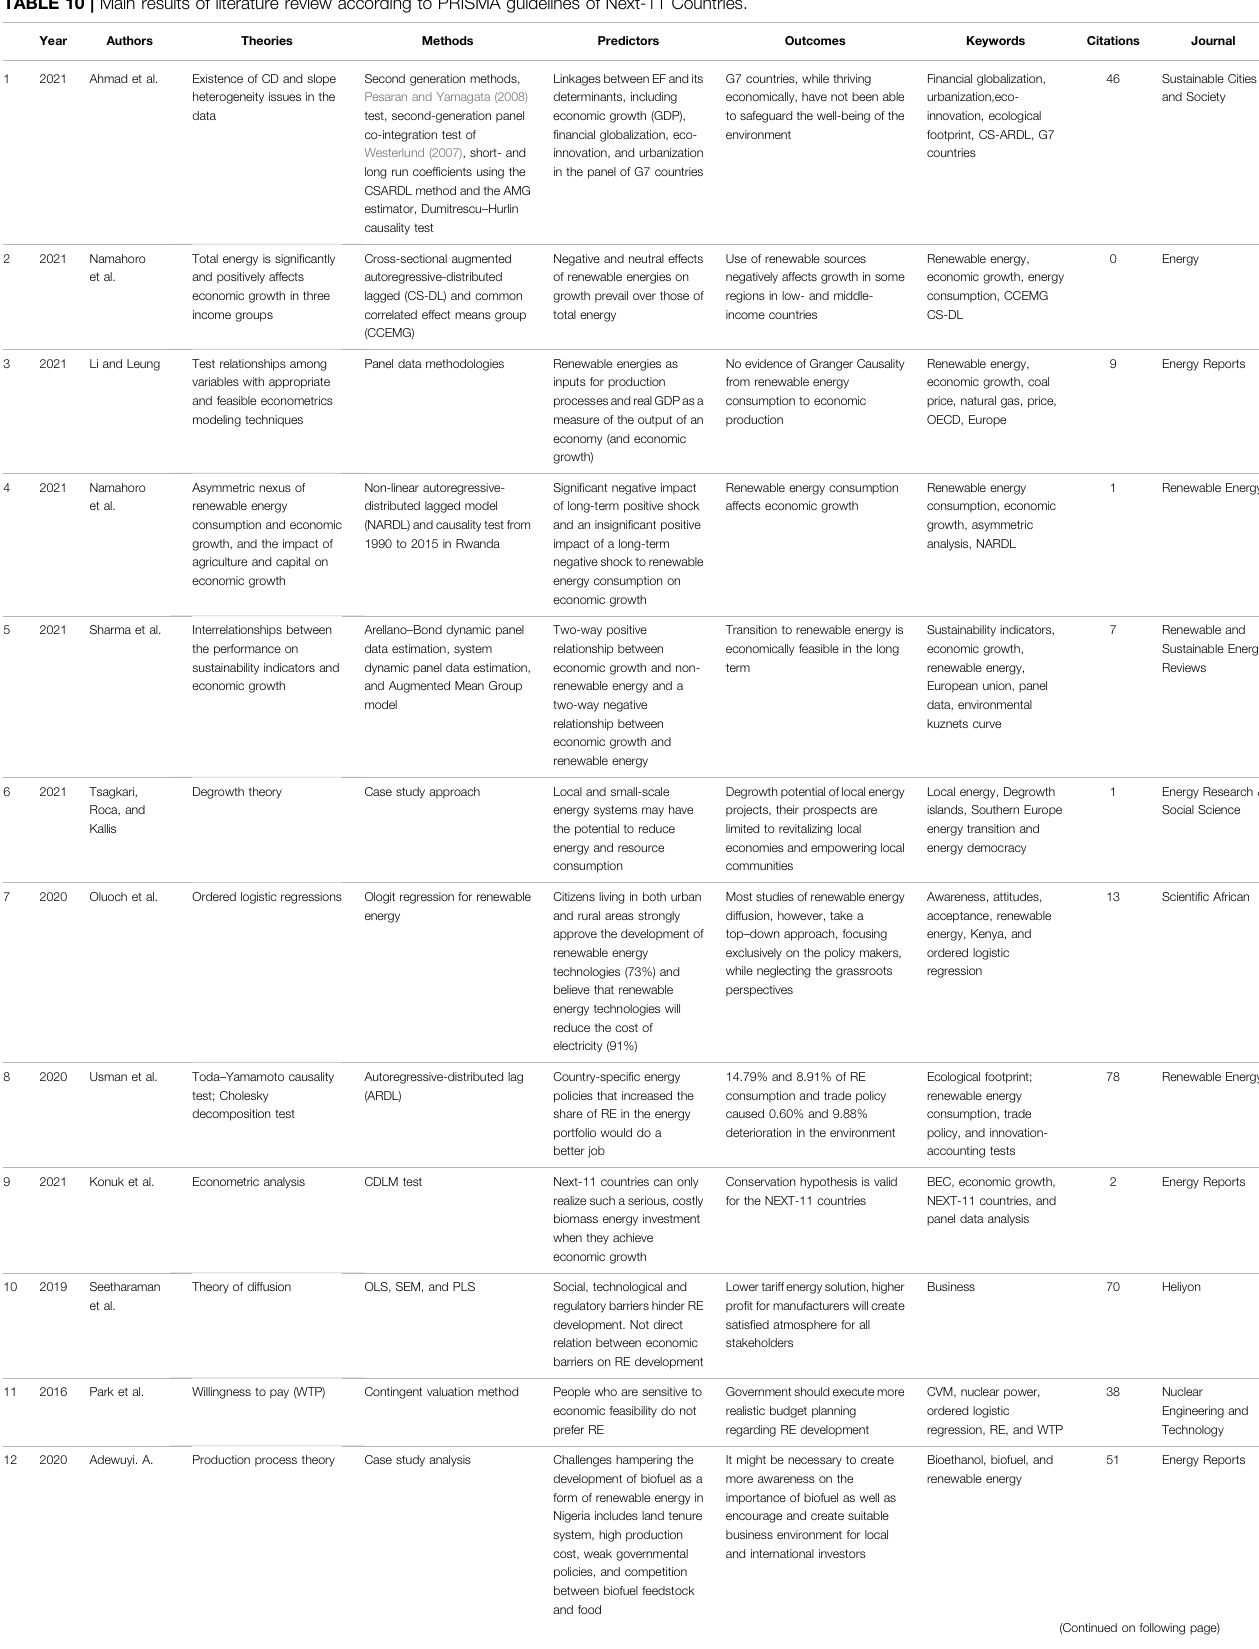
TABLE 10 | Main results of literature review according to PRISMA guidelines of Next-11